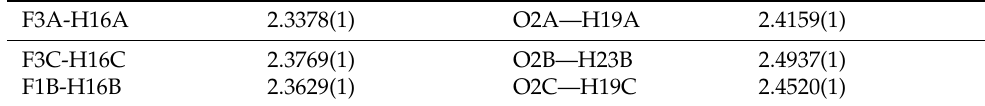
Table 3. Intramolecular hydrogen bonding distances in Å.